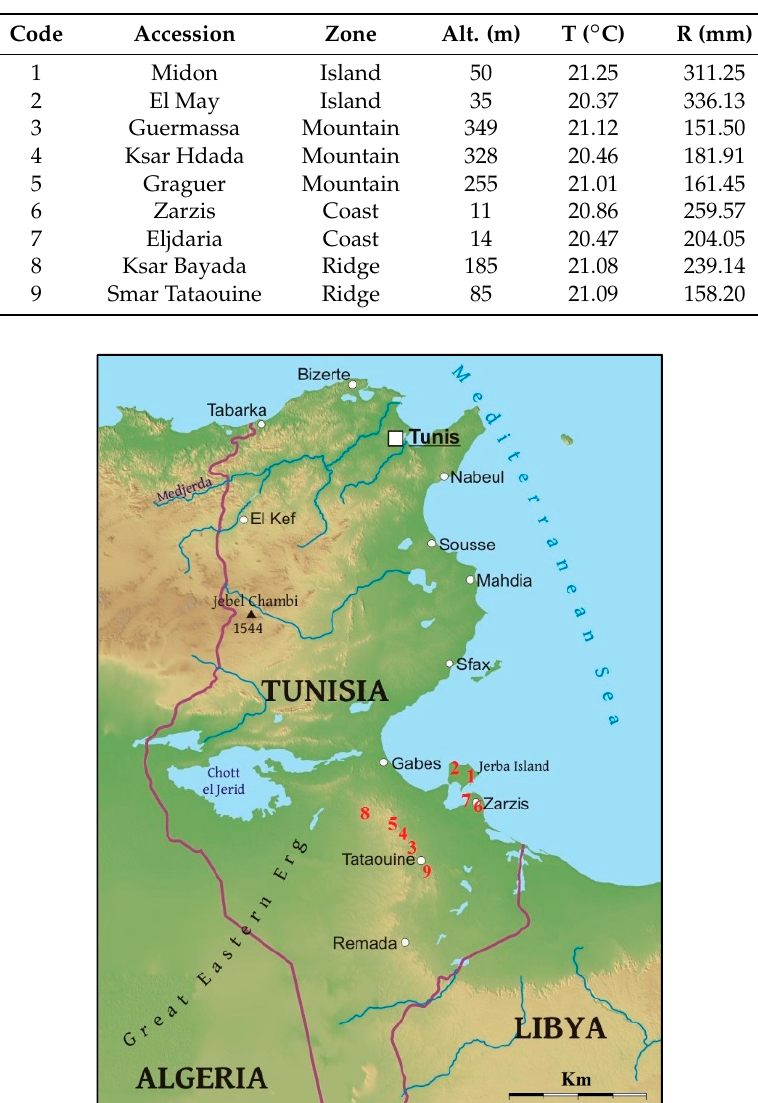
Table 3. Altitude, annual mean temperature (T) and annual rainfall (R) of the accessions of “Ardhaoui” barley landraces under study (The World Bank Group, Climate Change Knowledge Portal, reference period 1990–2012).